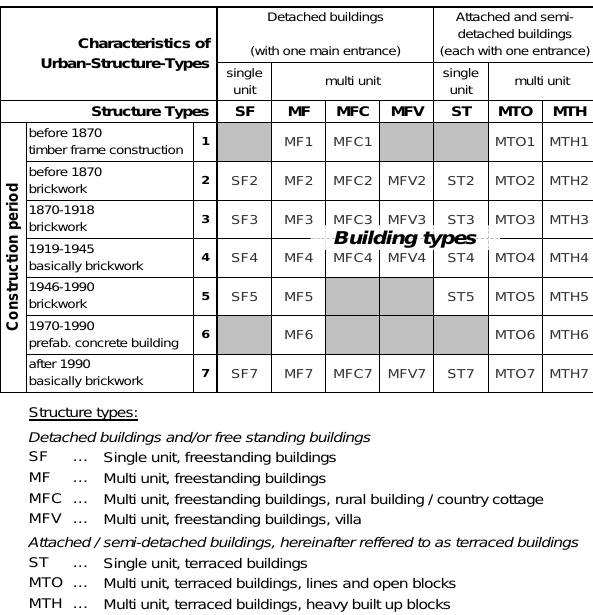
Fig. 2. Basic structure of a building type matrix for residential build- ings in Germany (following Neubert et al.,